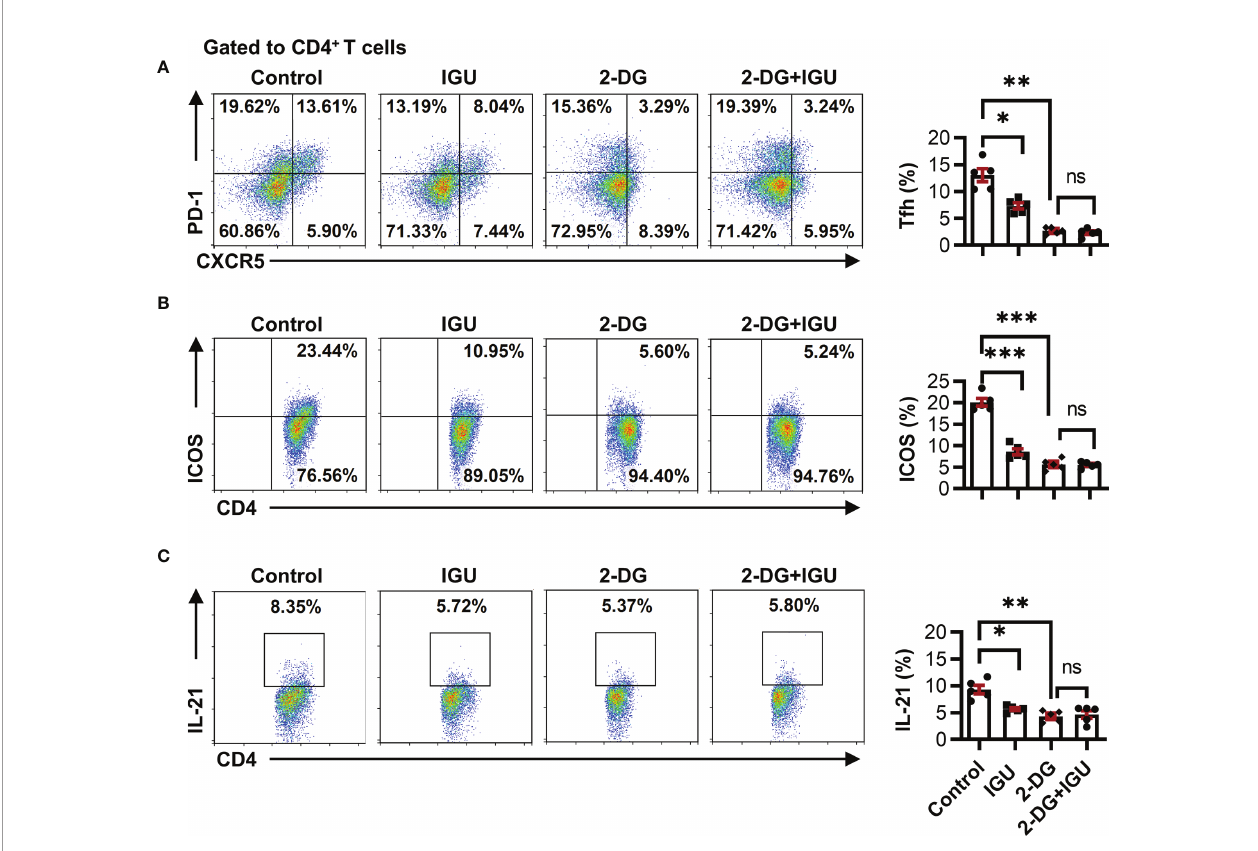
FIGURE 5 | IGU restrains the function of cTfh cells by inhibiting HK2. RA-PBMCs were activated by anti-CD3/CD28 antibody (2 m g/ml) and pretreated with HK2 inhibitor 2-DG or not for 4 hours, and then treated with IGU or DMSO for 3 days. (A – C) The frequencies of Tfh cells (A) , ICOS + CD4 + T cells (B) , and IL-21 producing CD4 + T cells (C) were determined by fl ow cytometry (n = 5). ns, no signi fi cance; * P < 0.05; ** P <0.01; *** P <